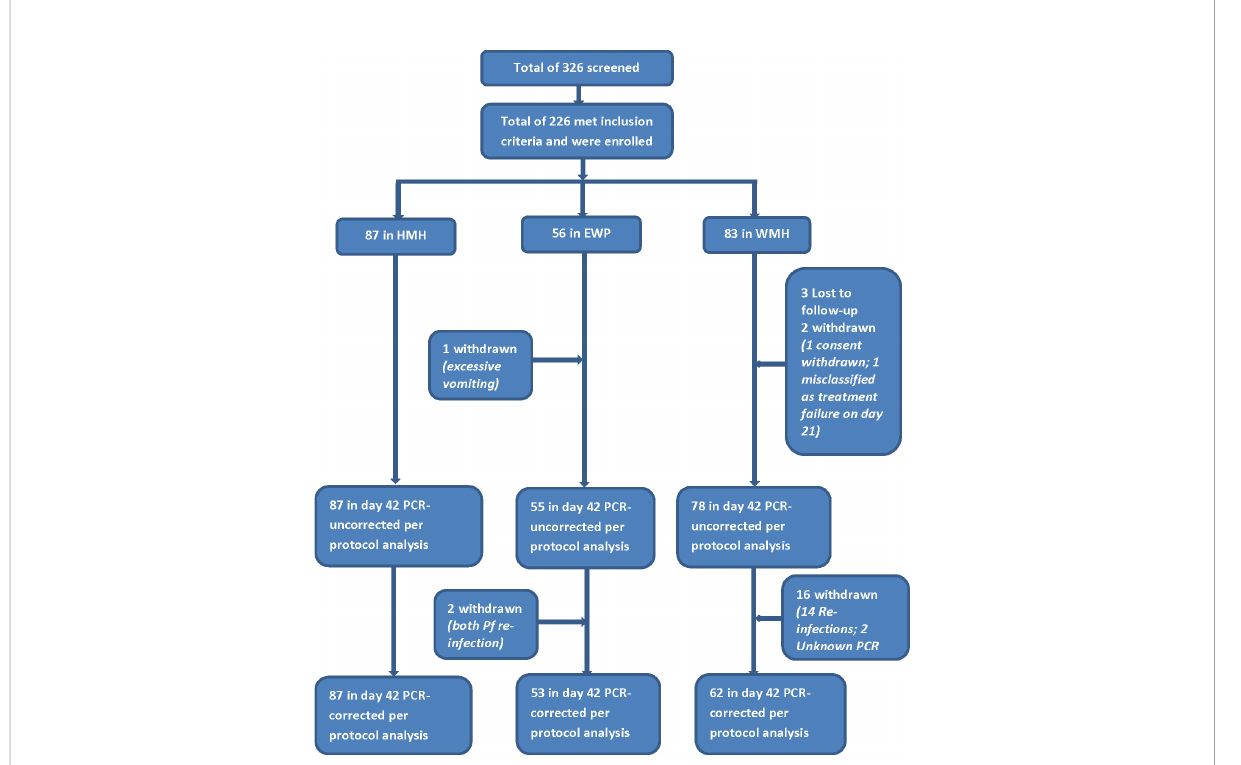
FIGURE 2 Flow chart showing number of children screened, enrolled, and included in per-protocol analysis. HMH Hohoe Municipal Hospital, EWP Ewim Polyclinic, WMH War Memorial